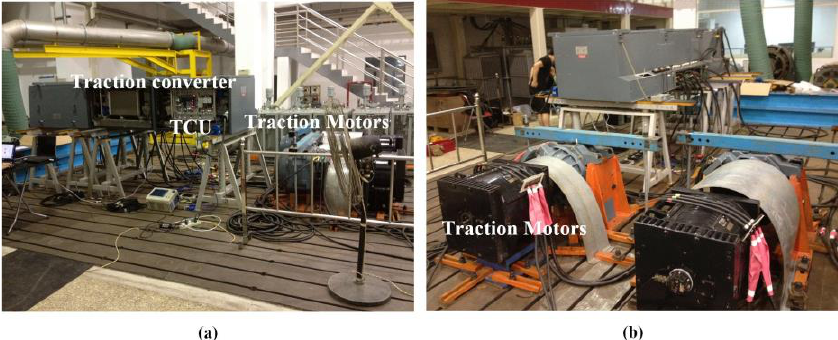
Figure 21. The back-to-back towing test platform with ( a ) overall view of the test platform and ( b ) side view of the test platform. Table 7. Parameters of the experiment